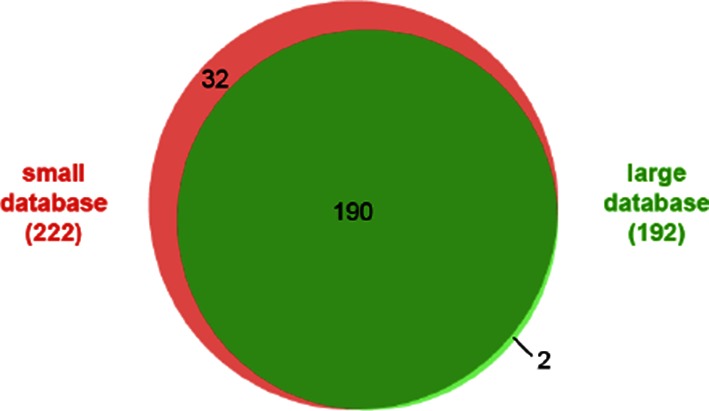
Comparison of identified cross-links using a small database (62 proteins) and a large database (562 proteins).Filtering criteria: FDR < 5%, E-value < 0.00001, and spectral count ≥ 5.